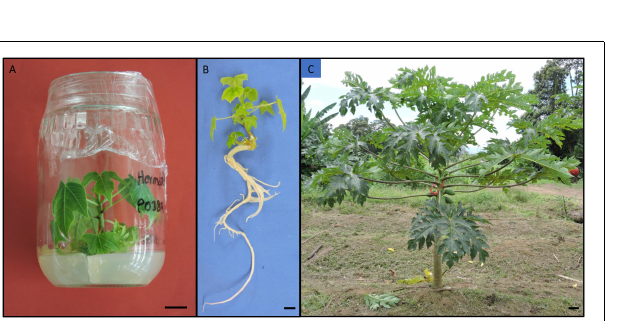
FIGURE 5 | Effect of different concentrations of BA (A) and Mtop (B) on the formation of callus at the basal section of the hybrid papaya somatic embryos after 4 weeks of culture. Different letters show significant differences ( p < 0.05) and bars indicate the standard error.